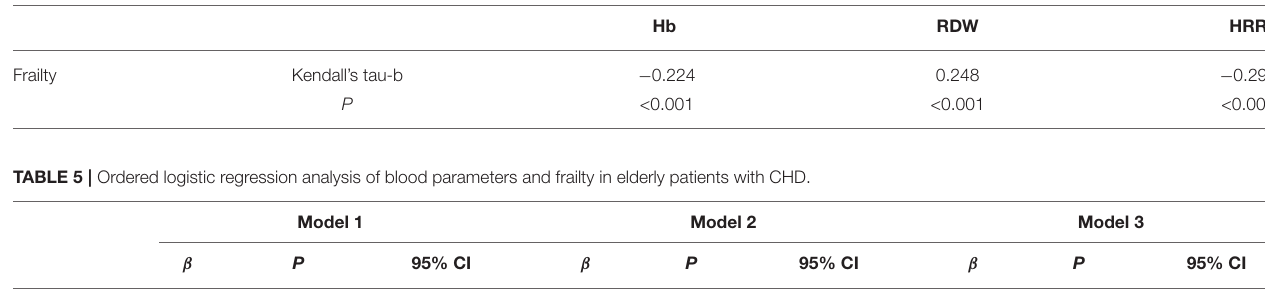
TABLE 4 | Correlation analysis of peripheral blood Hb, RDW, HRR, and frailty in elderly patients with CHD.